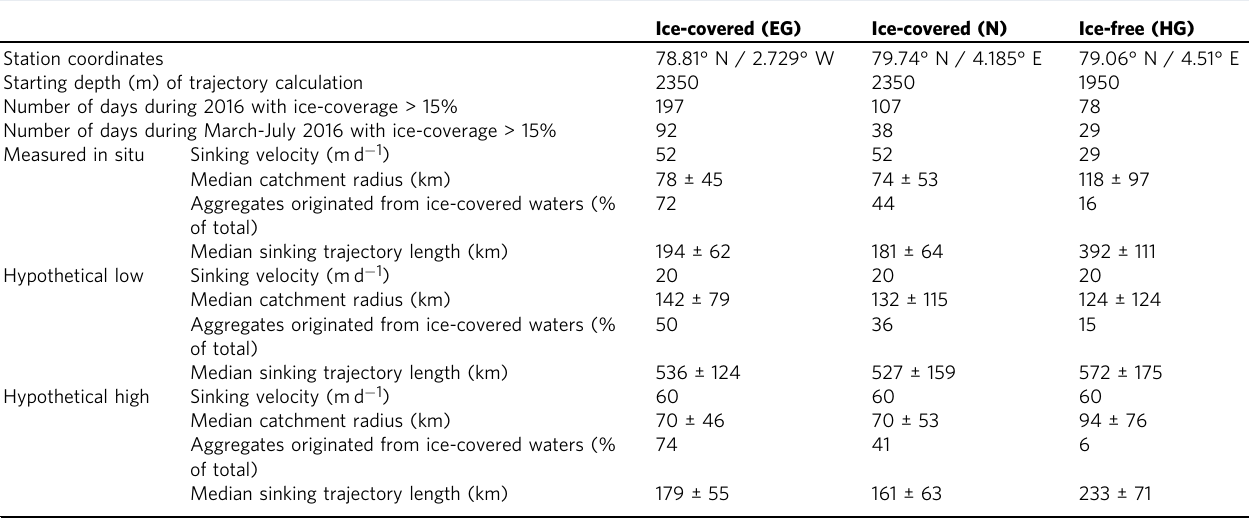
Table 1 Sinking aggregate trajectories characteristics of particles reaching the surface ocean between March 1st 2016 and July 31st 2016 in different regions of Fram